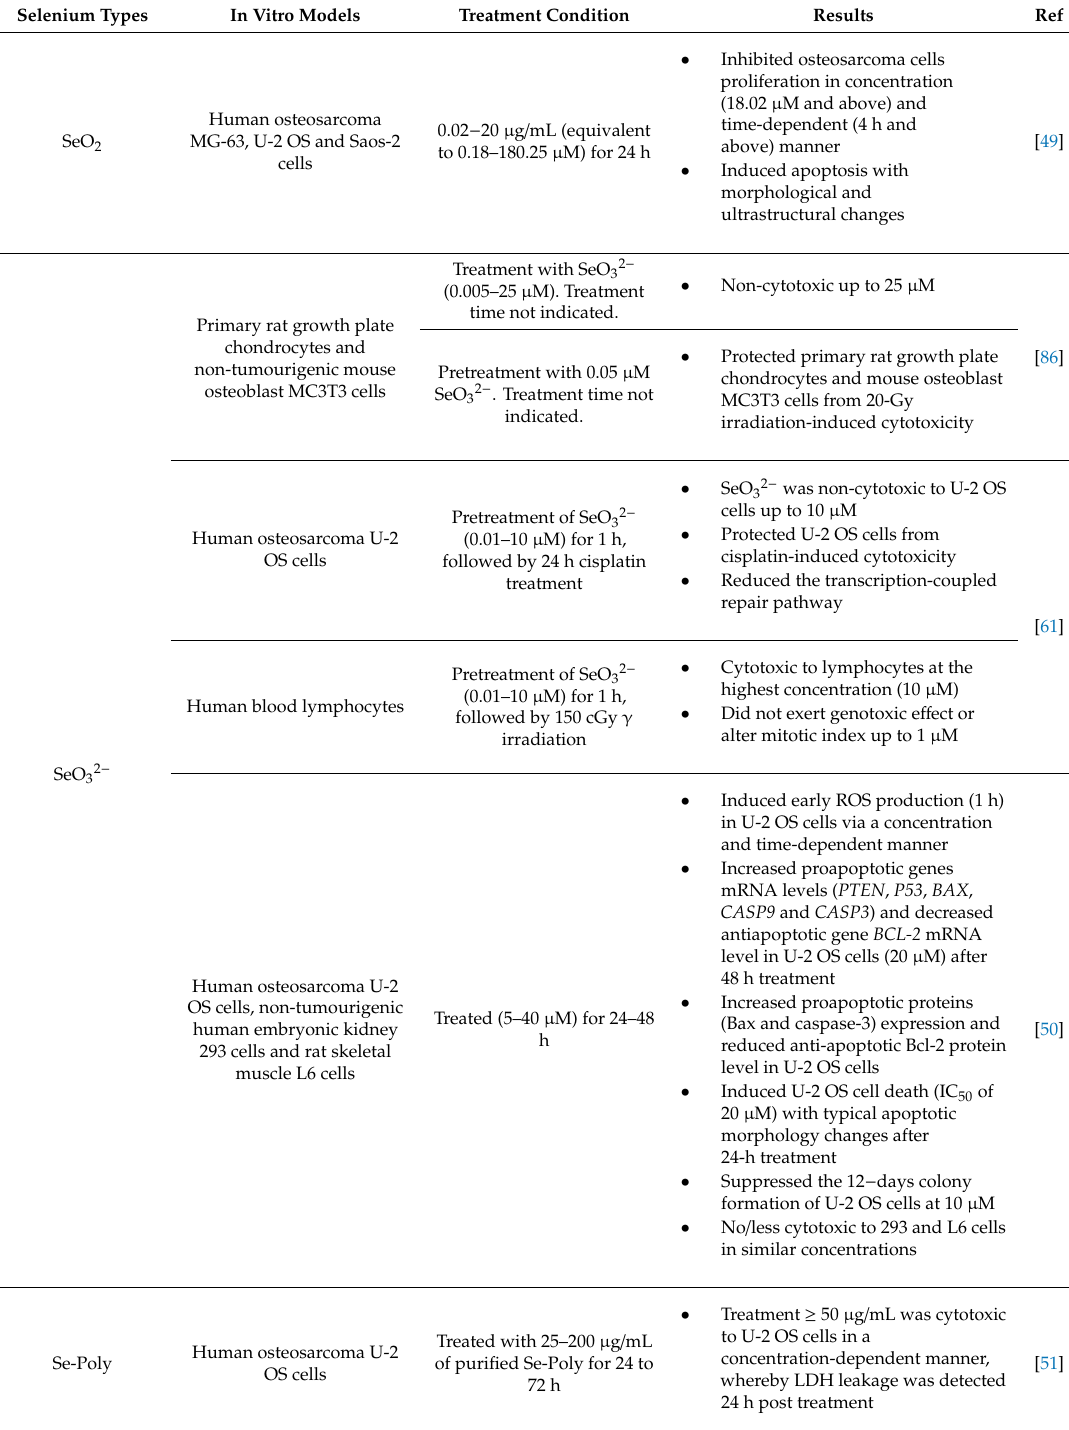
Table 1. The anticancer e ff ects of selenium from in vitro